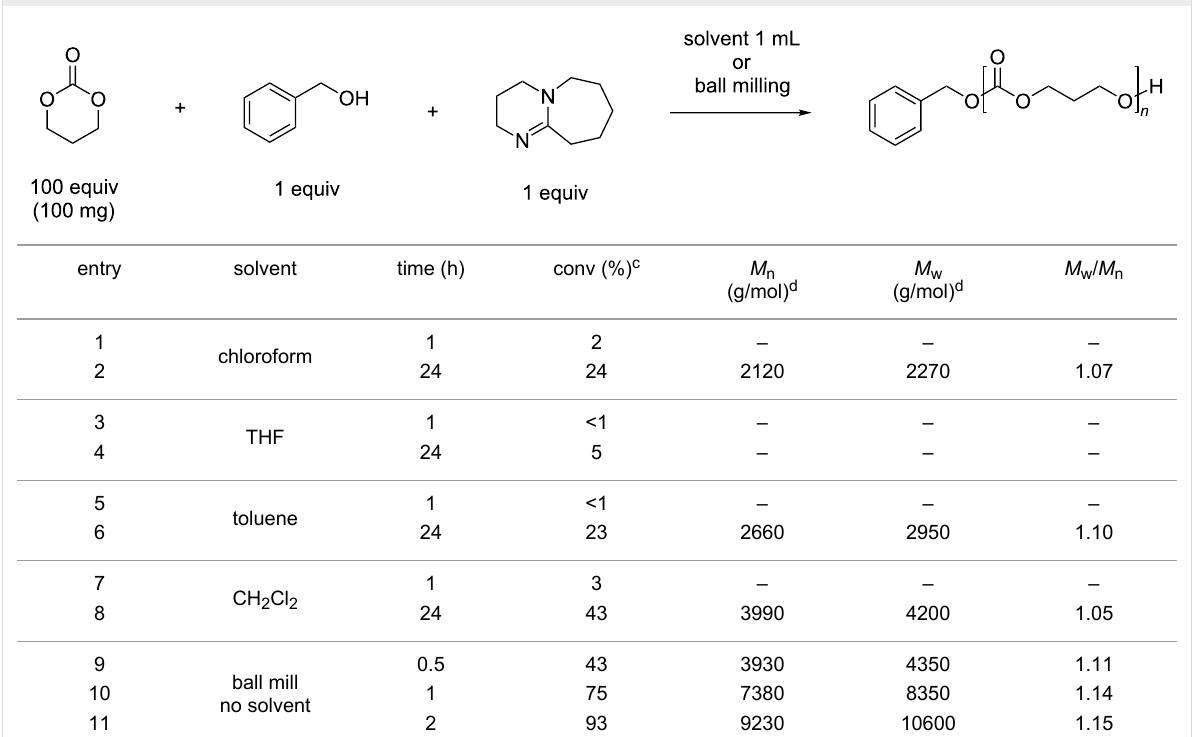
Table 1: DBU-catalyzed polymerization of trimethylene carbonate: solution vs ball milling. a,b